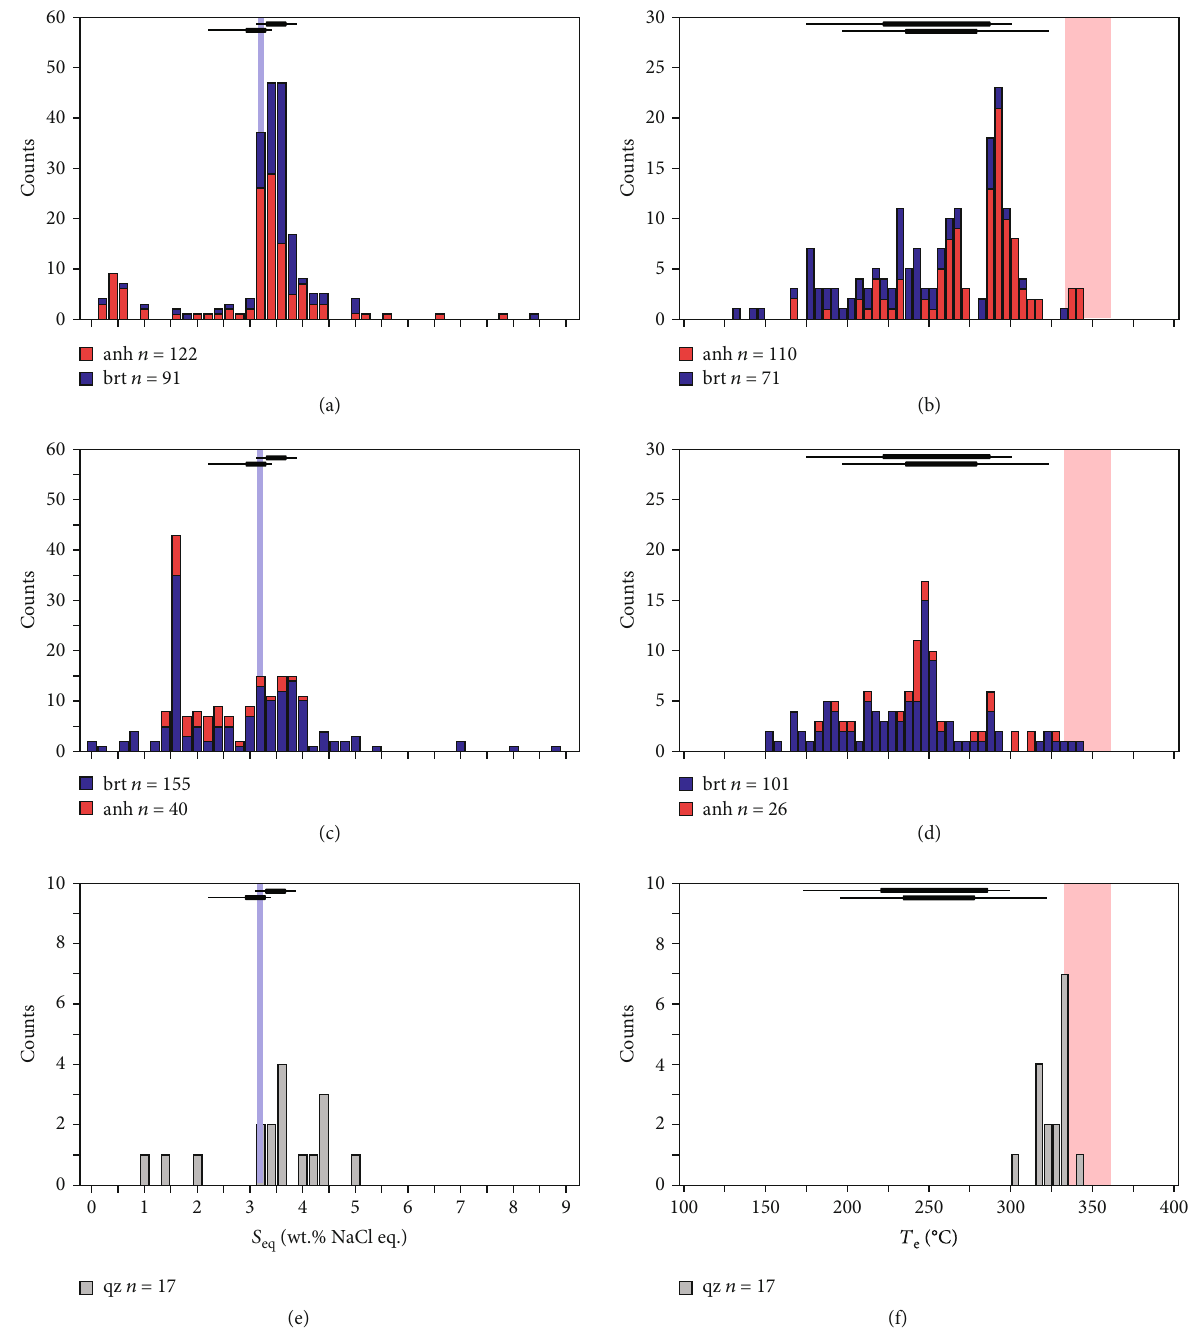
Figure 6: Histograms of salinities ( S T for fl uid inclusions from chimneys. (c, d) Histograms of S e open vugs in propyliticly altered wallrock adjacent to the stockwork veins. The inclusions are color coded after their host mineral; anh: anhydrite in red; brt: barite in blue; qz: quartz in grey. Explanation of black bars is given in Figure